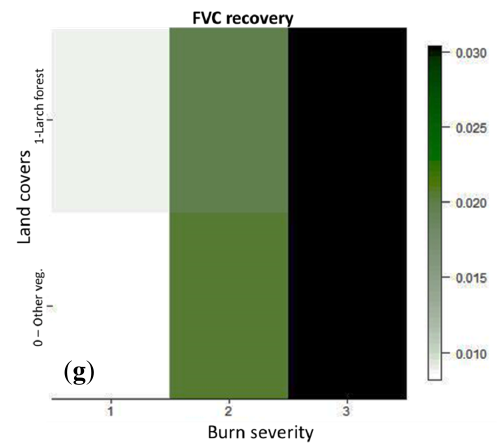
Figure 9. Interaction between burn severity and other environmental factors ( a : burn severity and elevation; b : burn severity and distance to water bodies; c : burn severity and temperature ‐ vegetation dryness index (TVDI); d : burn severity and solar insolation; e : burn severity and pre ‐ fire normalized difference vegetation index (NDVI); f : burn severity and slope; g : burn severity and pre ‐ fire land covers) in predicting the post ‐ fire vegetation recovery rate defined by FVC. In each interaction plot, the remaining predictor variables were fixed at their mean (for continuous predictors) or their mode (for categorical predictors). Values in the legends show the vegetation recovery rate measured by the FVC slope.